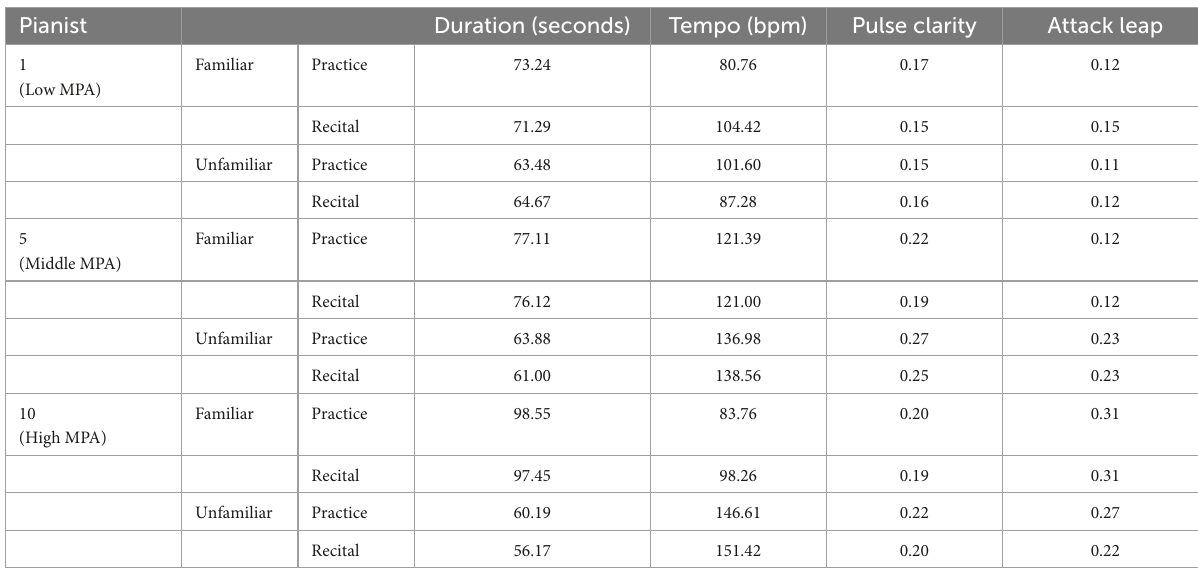
TABLE 3 Extracted musical features of pieces